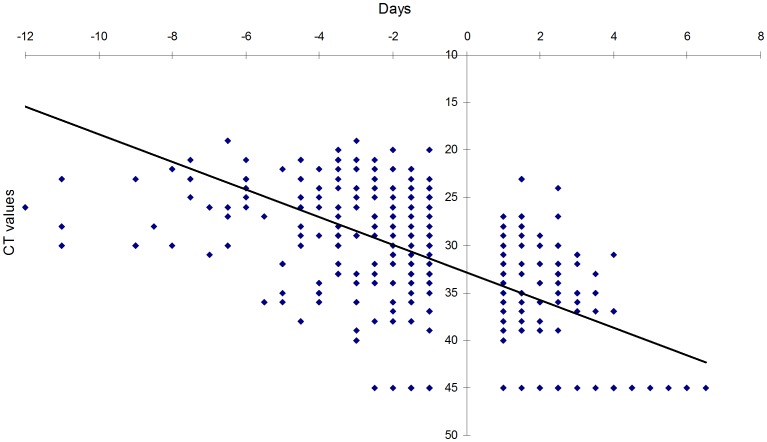
Comparison of CT values over time in relation to RIFT.The insertion of y-axis reflects the “switch” from positive to negative RIFT.